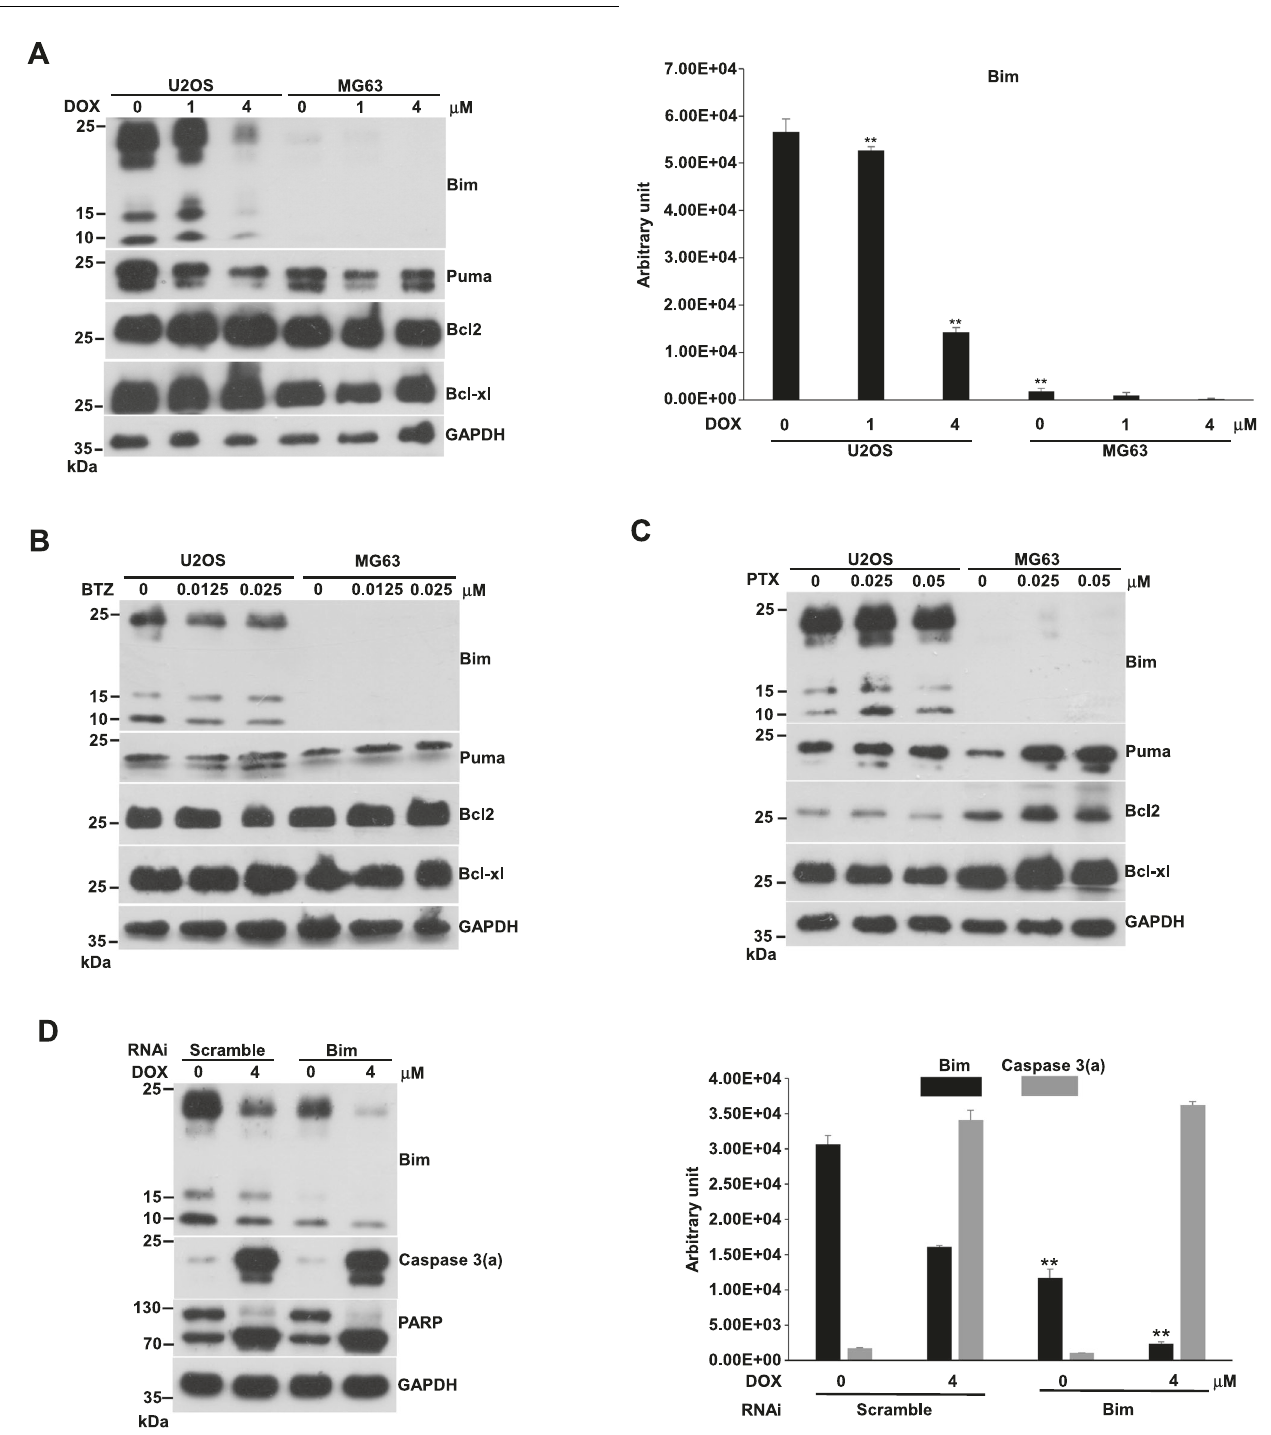
Fig. 2 Expression of Bcl2, Bcl-xl, Bim, and Puma in U2OS and MG63 cells with/without DOX, BTZ, and PTX treatment and the knockdown of Bim in U2OS cells. Cells were incubated with various concentrations of DOX, BTZ, or PTX on 10-cm plates for 24 h and harvested for western blotting. The immunoblot images of Bcl2, Bcl-xl, Bim, and Puma were shown. GAPDH served as a loading control. The immunoblot images of Bim normalized to GAPDH were quantitated as shown beside the right side of the immunoblot image in DOX-treated U2OS and MG cells (** P < 0.01). For Bim knockdown, U2OS cells were transfected with the Bim speci fi c or scramble RNAi and then were treated with 0 and 4 μ M of DOX for 24 h. Cells were harvested for western blotting. The immunoblot images of Bim and caspase 3(a) were shown. GAPDH served as a loading control. The immunoblot images of Bim and caspase 3(a) normalized to GAPDH were quantitated as shown beside the right side of the immunoblot image (** P < 0.01). The immune blots were cropped from different parts of the same gels and visualized by ECL with various exposure conditions dependent on antibody activity. Representative blots from triplicate experiments were shown. A U2OS and MG63 cells were treated by DOX. B U2OS and MG63 cells treated by BTZ. C U2OS and MG63 cells treated by PTX. D The Bim knockdown in U2OS.